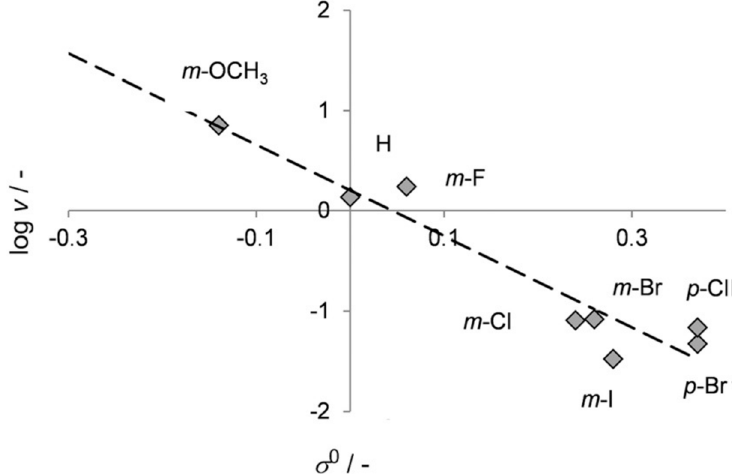
Figure 20. Correlation of the logarithm of the calculated initial reaction rates ( v ) with respect to the Taft constants ( σ 0 ) for the selected set of substrates shown in Figure 18, (R 2 = 0.92). Reprinted with permission from [76]. Copyright 2016, John Wiley and Sons.